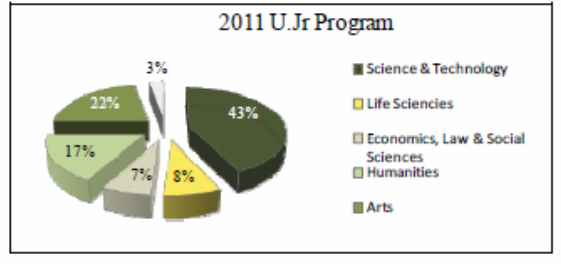
Figure 3. Thematic areas in U.Jr. 2011 [5] From the U.Jr. inception in 2005 the number of partici- pants has quickly risen to around five thousand who come from all over the country and even from abroad (United States, Brazil, France, England, Spain, Ireland, Holland, Macau, Angola, Mozambique, St. Tomé and Príncipe). The geographical distribution patterns of recruitment areas for both U.Jr. participants in 2006-2010 and U.Porto students in 2007-2011 are compared in Fig. 4. They are not significantly different (with a Pearson index of 0.95) with U.Jr. exhibiting a slightly wider geographical disper- sion [5].